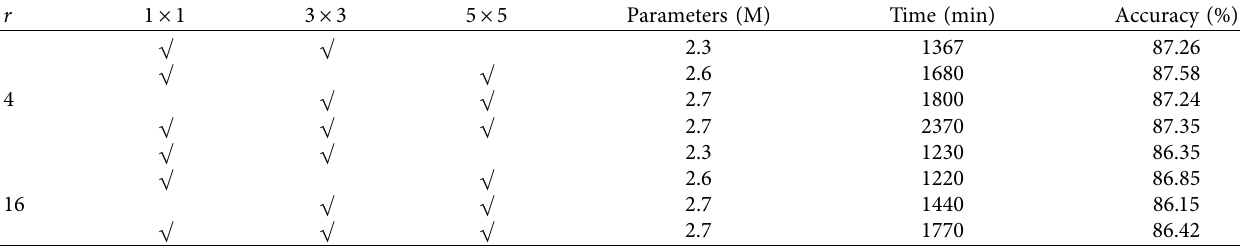
Table 2: Comparison of r value and convolution kernel size classification